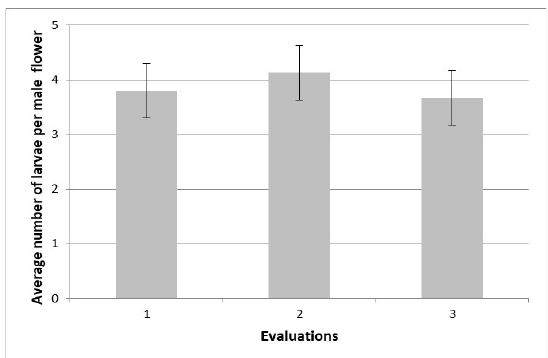
Figure 5. The average number of larvae of Prodiplosis longifila (in 2nd-stage) evaluated in male asparagus flowers. Virú, La Libertad - Perú, May-June.